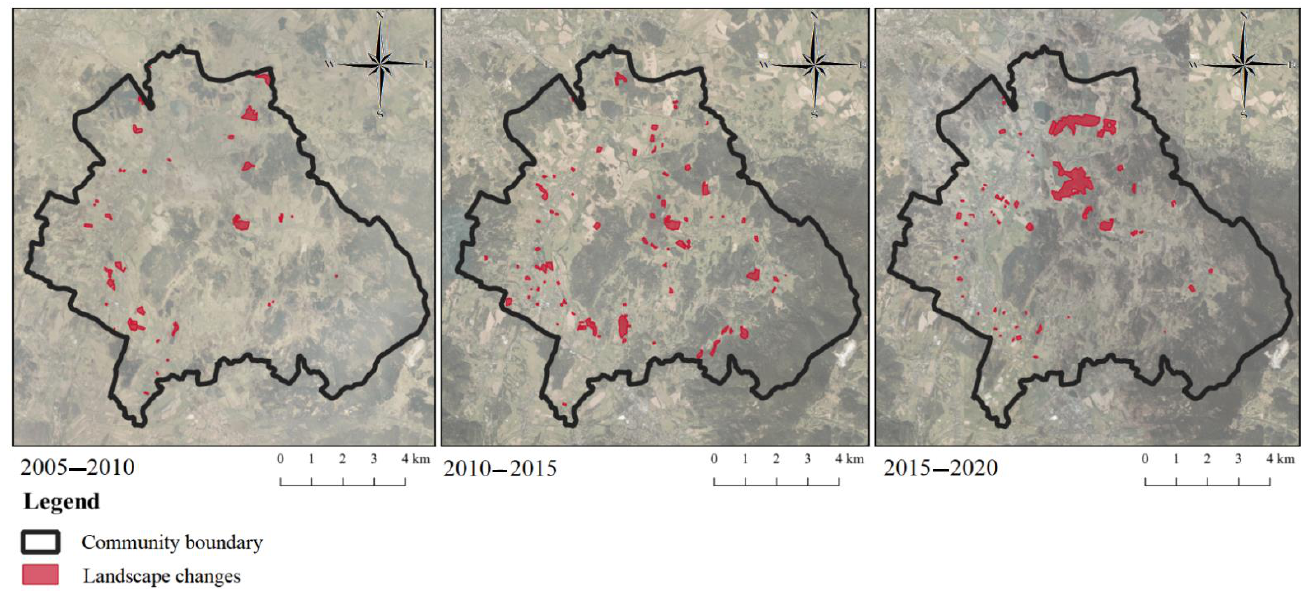
Figure 3. Location of the landscape changes in the Mysłakowice commune in 2005–2010, 2010–2015 and, 2015 – 2020, respectively.